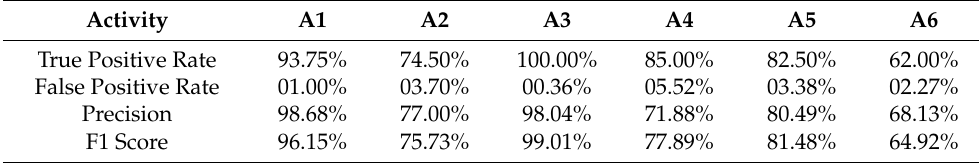
Table 15. The results of our proposed approach obtained for the fifth evaluation